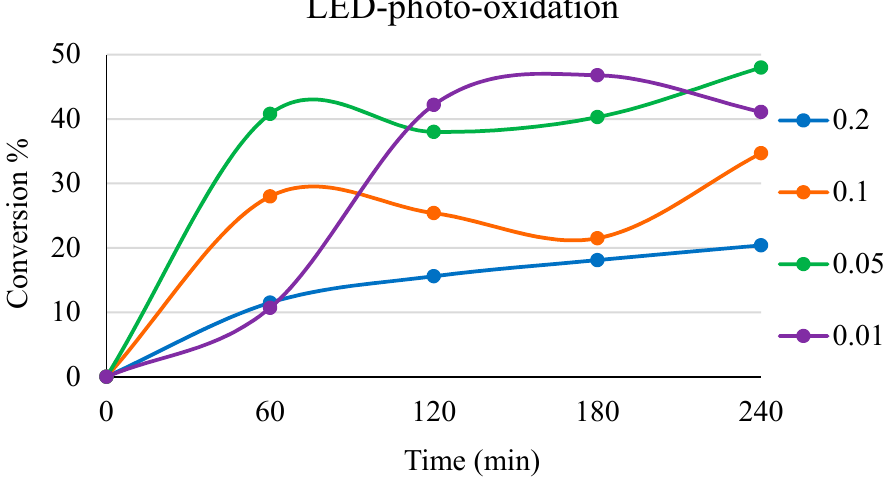
Figure 5. Photo-oxidation of NH 4+ at various substrate/catalyst ratios (0.01–0.2 mol/g under LED lamp irradiation, using 0.01 mol of NH 4 Cl, 0.1%Ag/FSP as a photocatalyst in different amounts), pH 5, r.t. and 250 mL of solution.